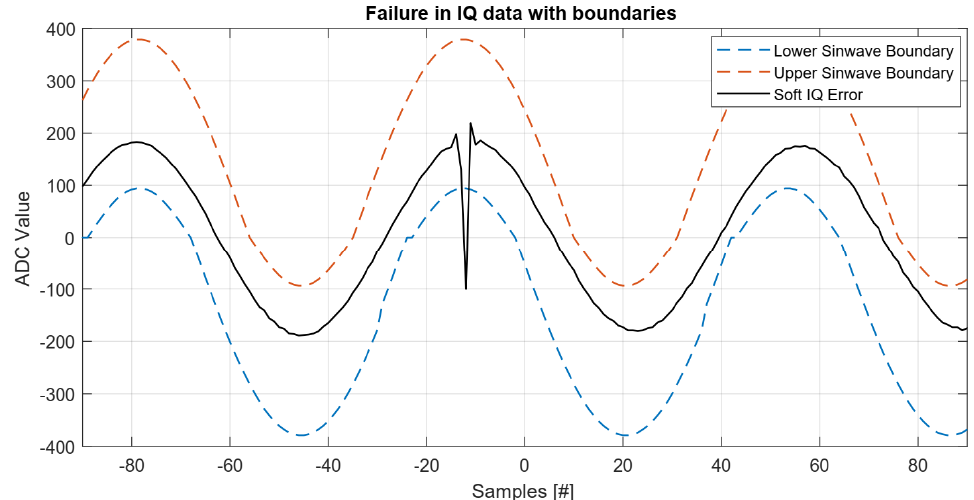
Figure 8. Reference curve with its boundaries for the in-phase / quadrature (IQ) data validation with a Soft IQ single event functional interrupts (SEFI).